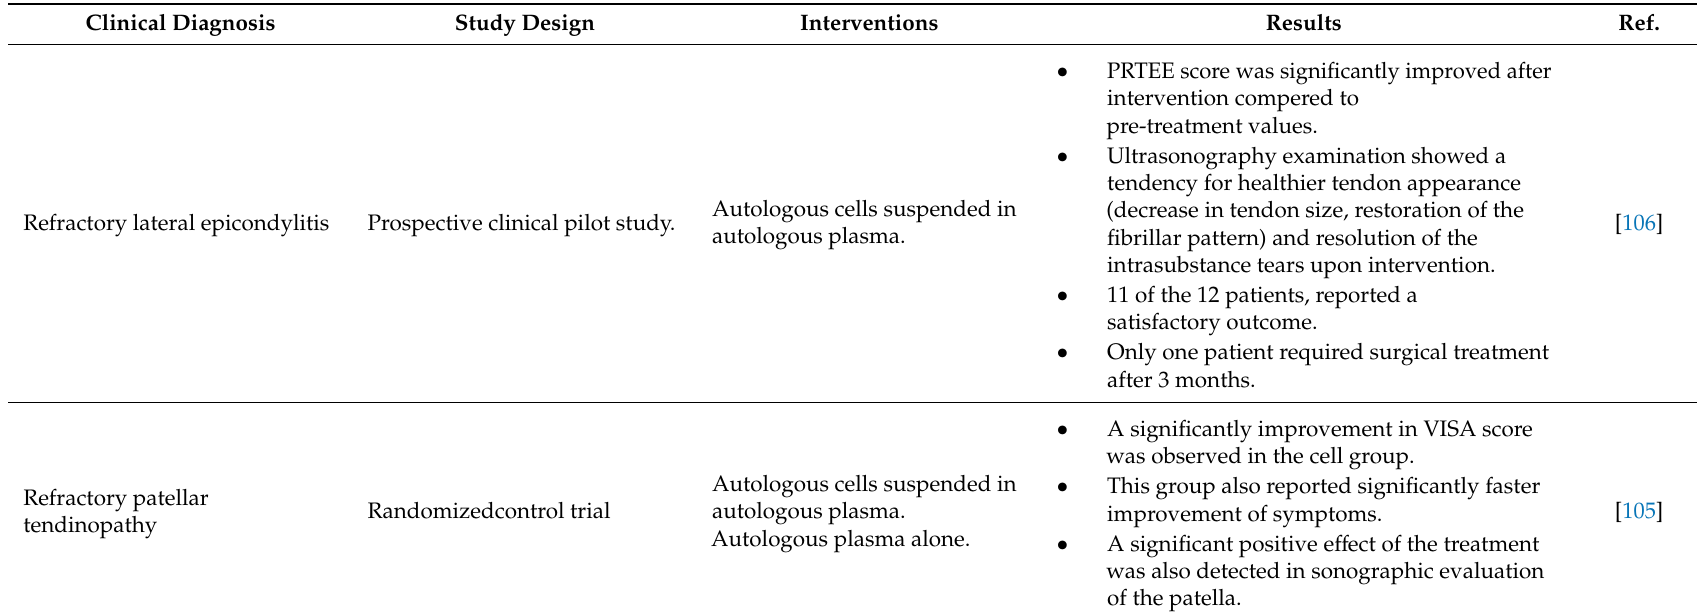
Table 4. Clinical application in tendon reparation (in chronological